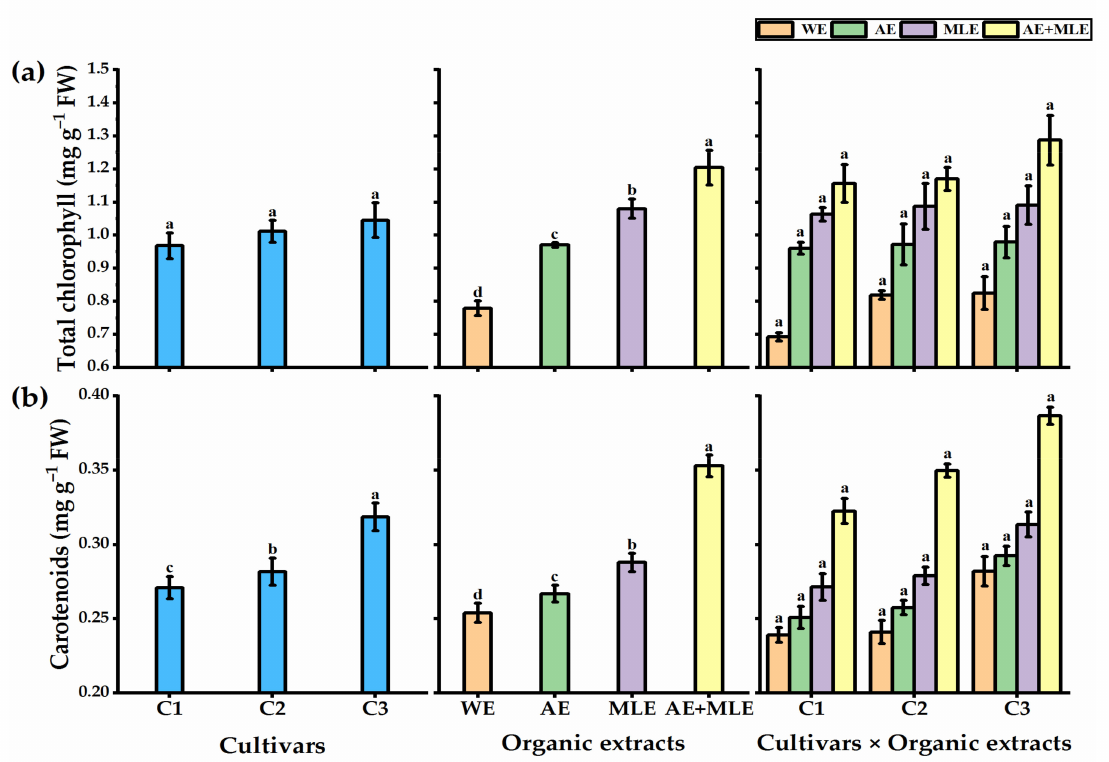
Figure 3. Effect of Azolla extract, moringa leaf extract, and their combination on ( a ) total chlorophyll (mg g − 1 FW), and ( b ) carotenoids (mg g − 1 FW) of three quinoa cultivars. C1 = KVL − SRAZ, C2 = Chipaya, C3 = Q − 37, WE = without extract, AE = Azolla extract, MLE = moringa leaf extract. Data are mean value ± SE, n = 3. Different letters denote significant differences at p ≤ 0.05